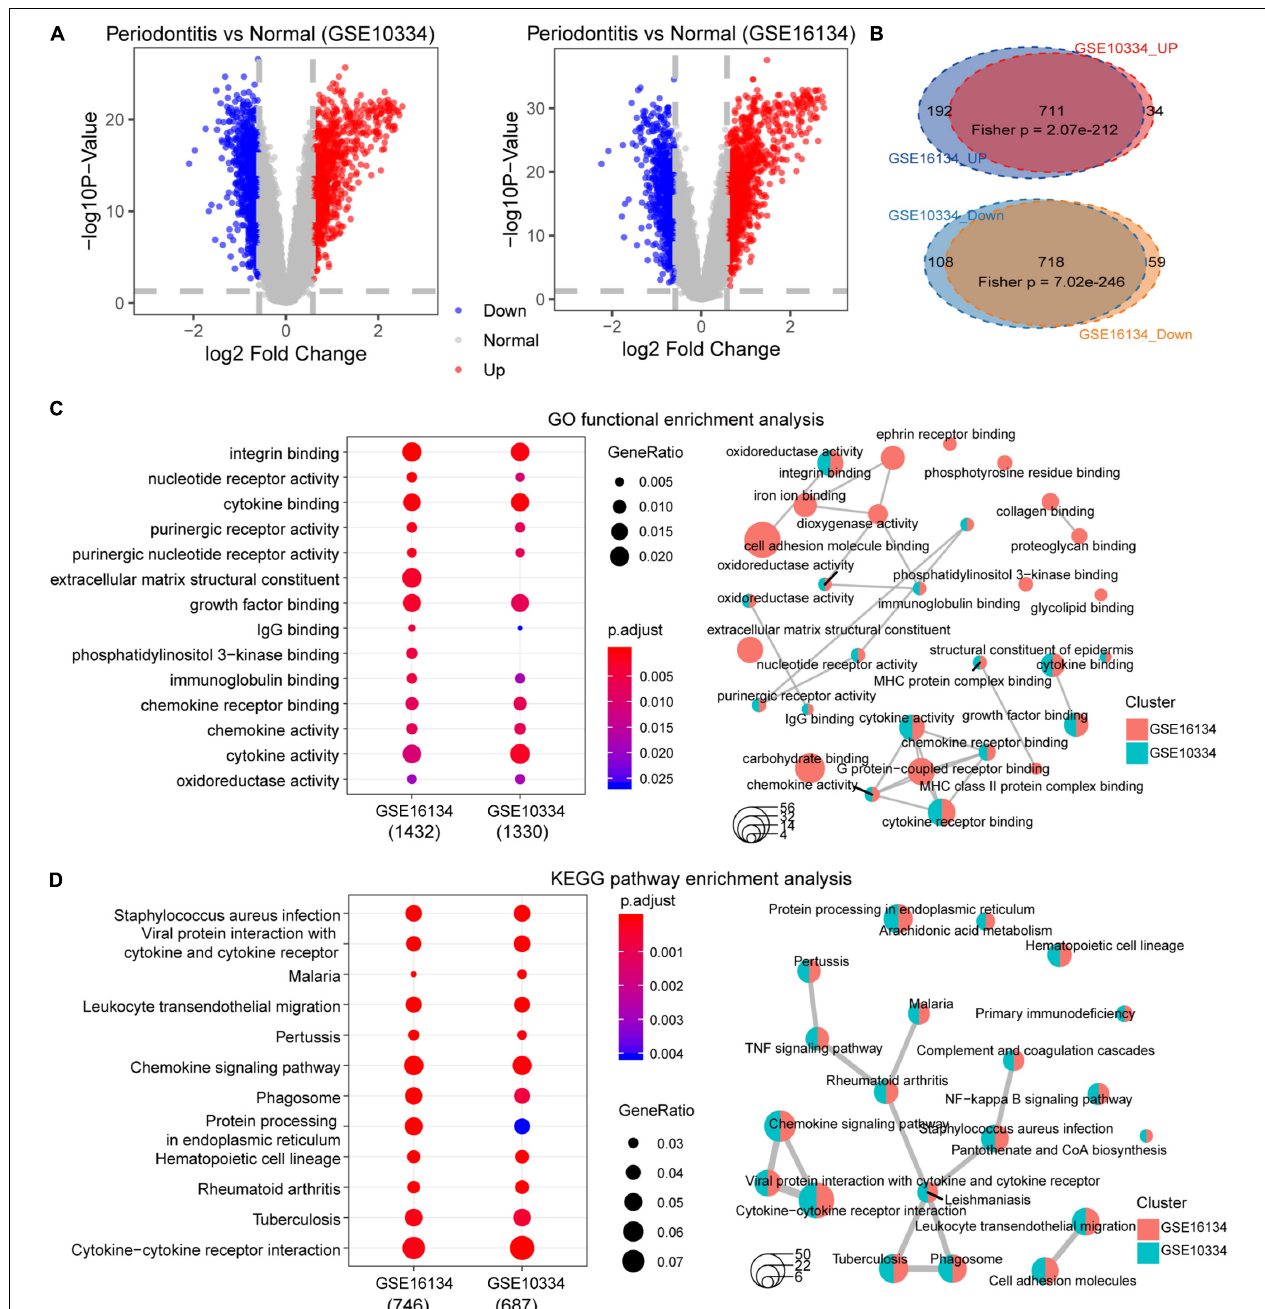
FIGURE 3 | Differential expression analysis and functional enrichment analysis between periodontitis and normal samples. (A) This picture represents the volcano map of DEGs for the GSE10334 series. (B) This venn diagram describe the intersection of the up- and down-regulated genes in the GSE10334 and GSE16134 series. Fisher’s exact test is used to measure the significance level of overlap. (C–D) This picture represents the dotplot and emapplot of the GO function enrichment node of DEGs in the GSE10334 and GSE16134 series of samples. e represents the dotplot and emapplot of the DEGs KEGG pathway enrichment in GSE10334 and GSE16134 series